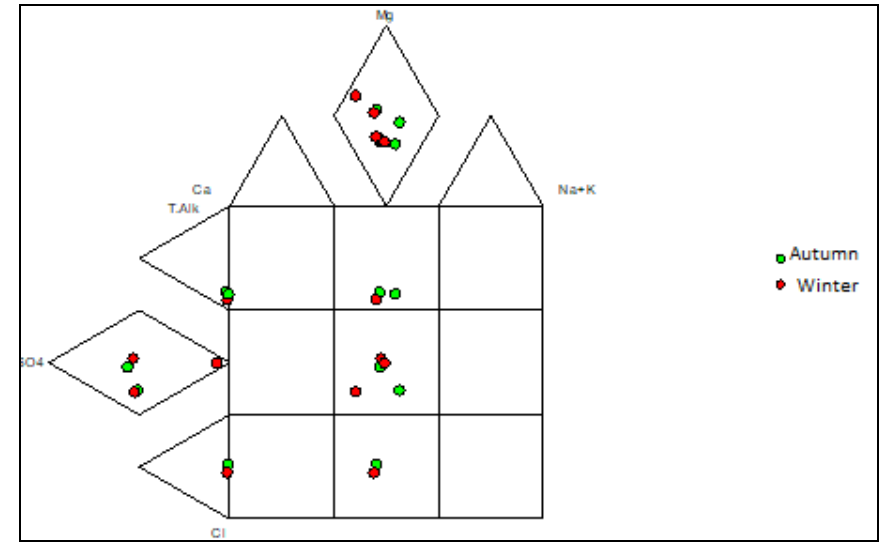
Figure 5. Expanded Durov diagram for groundwater samples in the northern landfill site for the two seasons.